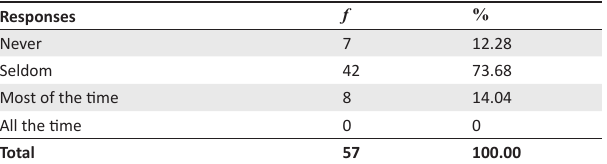
TABLE 11: Respondents’ views on how often community nurses contract tuberculosis whilst working with tuberculosis patients ( n = 57).